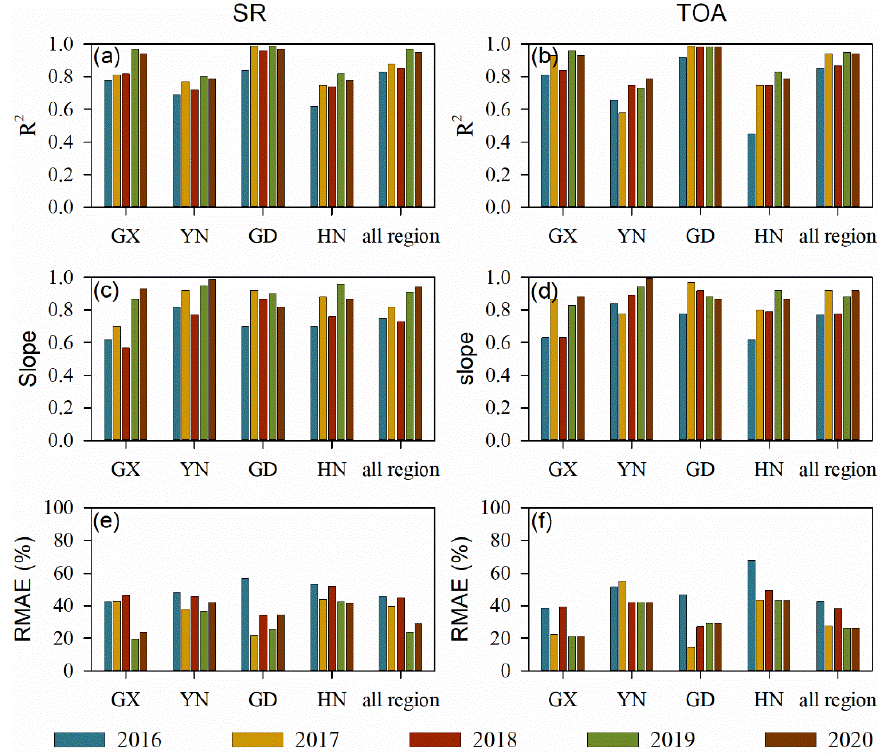
Figure 9. Correlations between the estimated and agricultural statistical planted areas of sugarcane (R 2 , slope, and RMAE) at the municipal level in China for each year from 2016 to 2020.